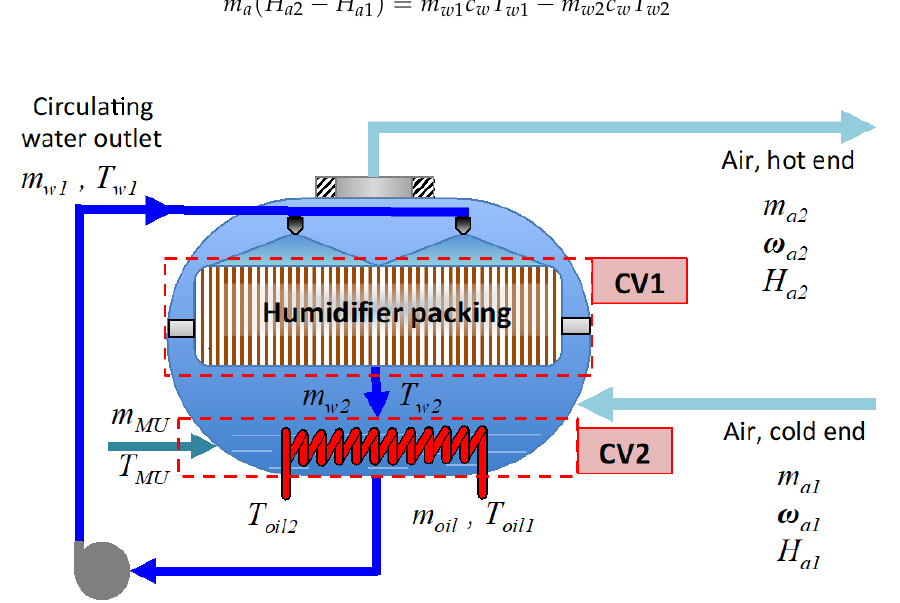
Figure 8. Schematic of the humidifier balance.